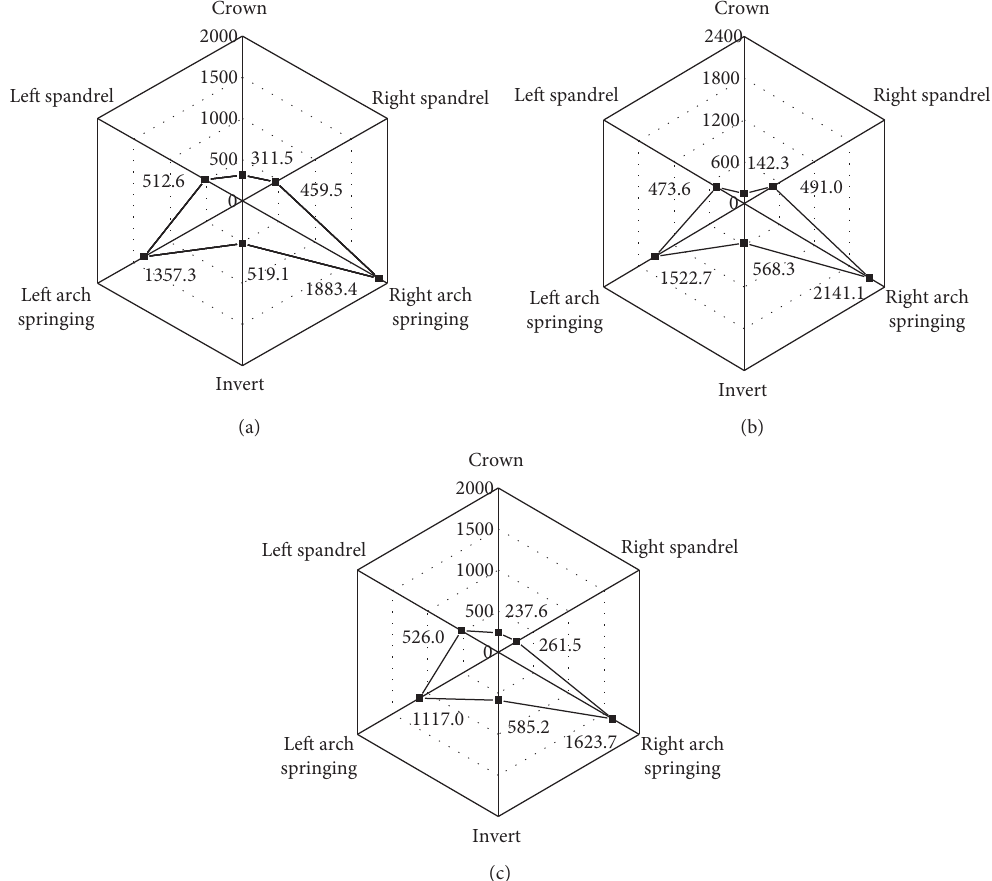
Figure 6: Peak elastic strain energy diagrams of tunnel structures with different Poisson’s ratios (unit: J). (a) 0.2; (b) 0.3; (c)